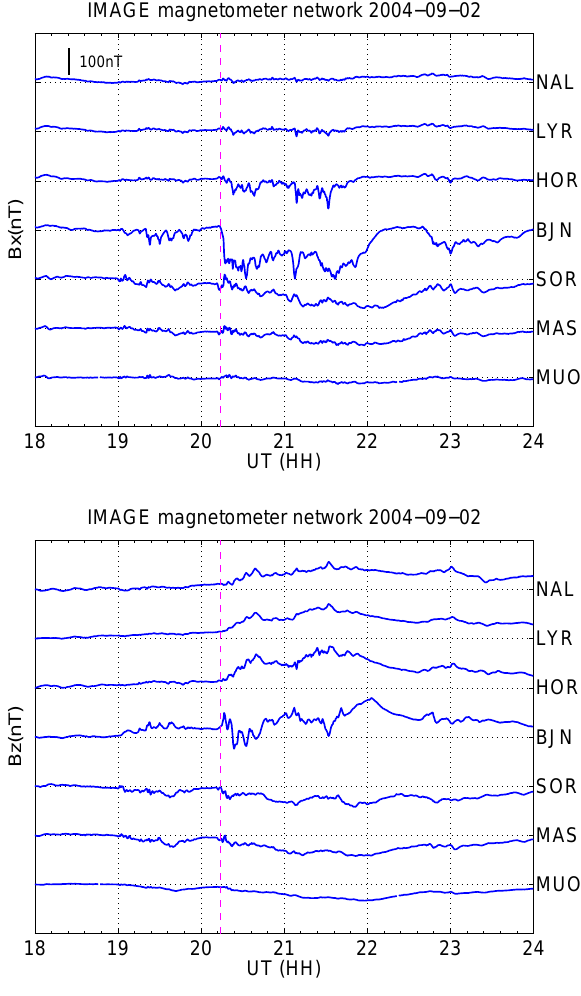
Fig. 3. Magnetograms from the International Monitor for Auroral Geomagnetic Effects (IMAGE) for the substorm under study. The red dashed line denotes the substorm onset.